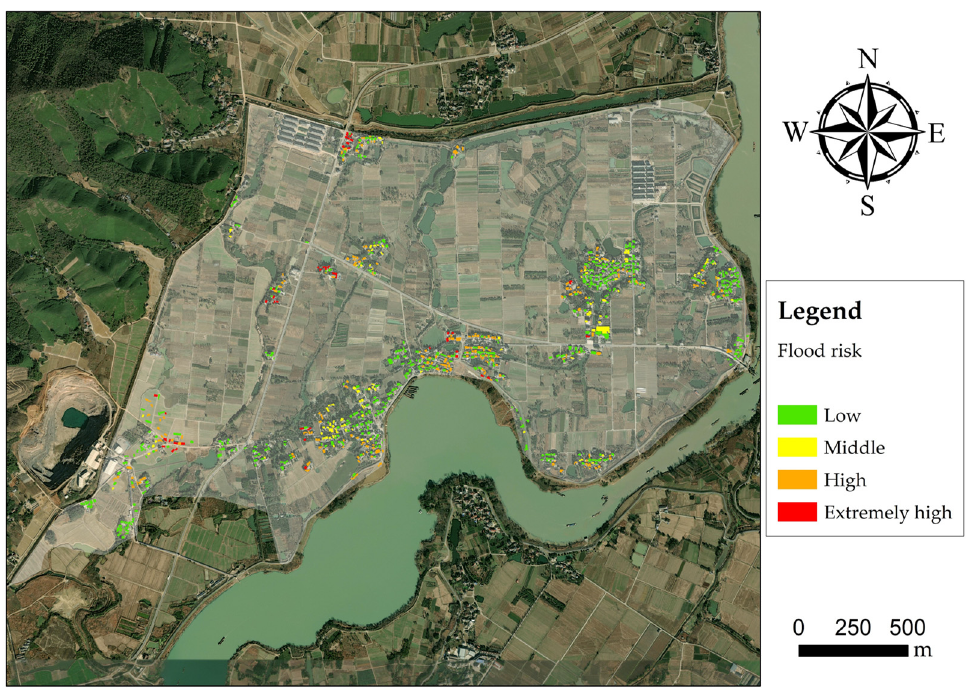
Figure 12. Flood risk assessment of buildings in flood scenario of 20-year return period.